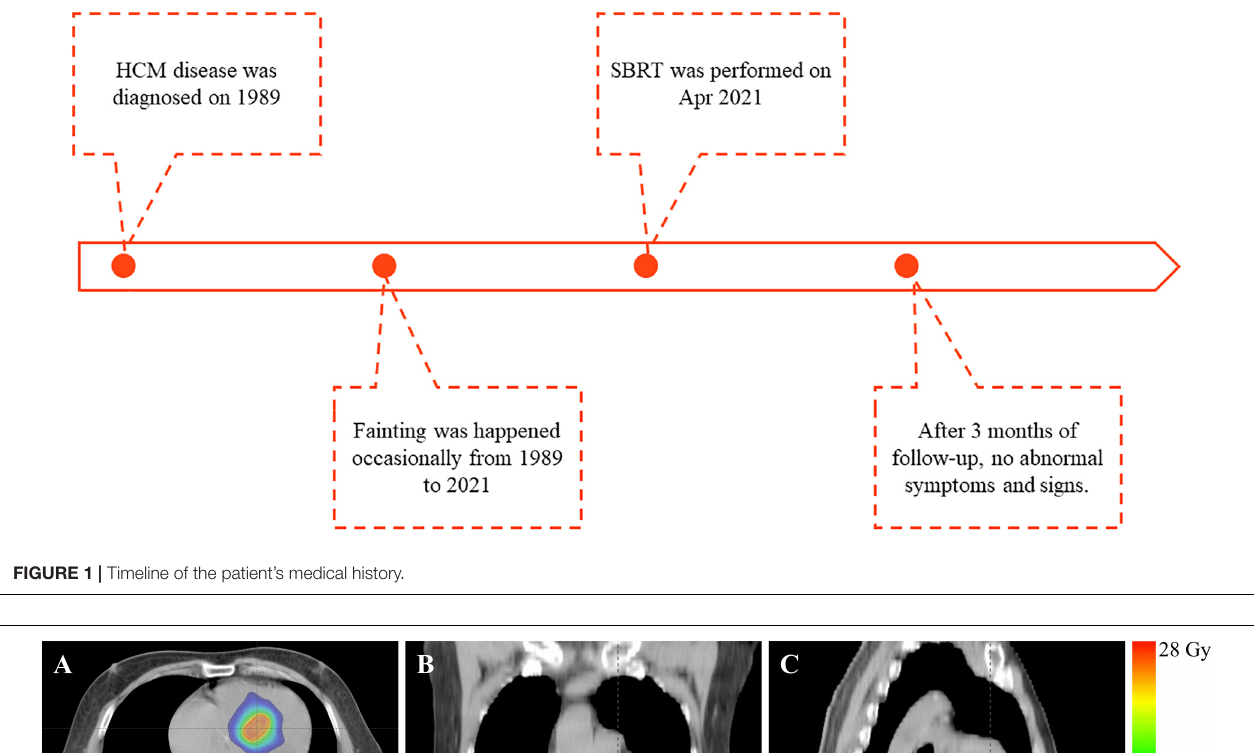
FIGURE 1 | Timeline of the patient’s medical history.